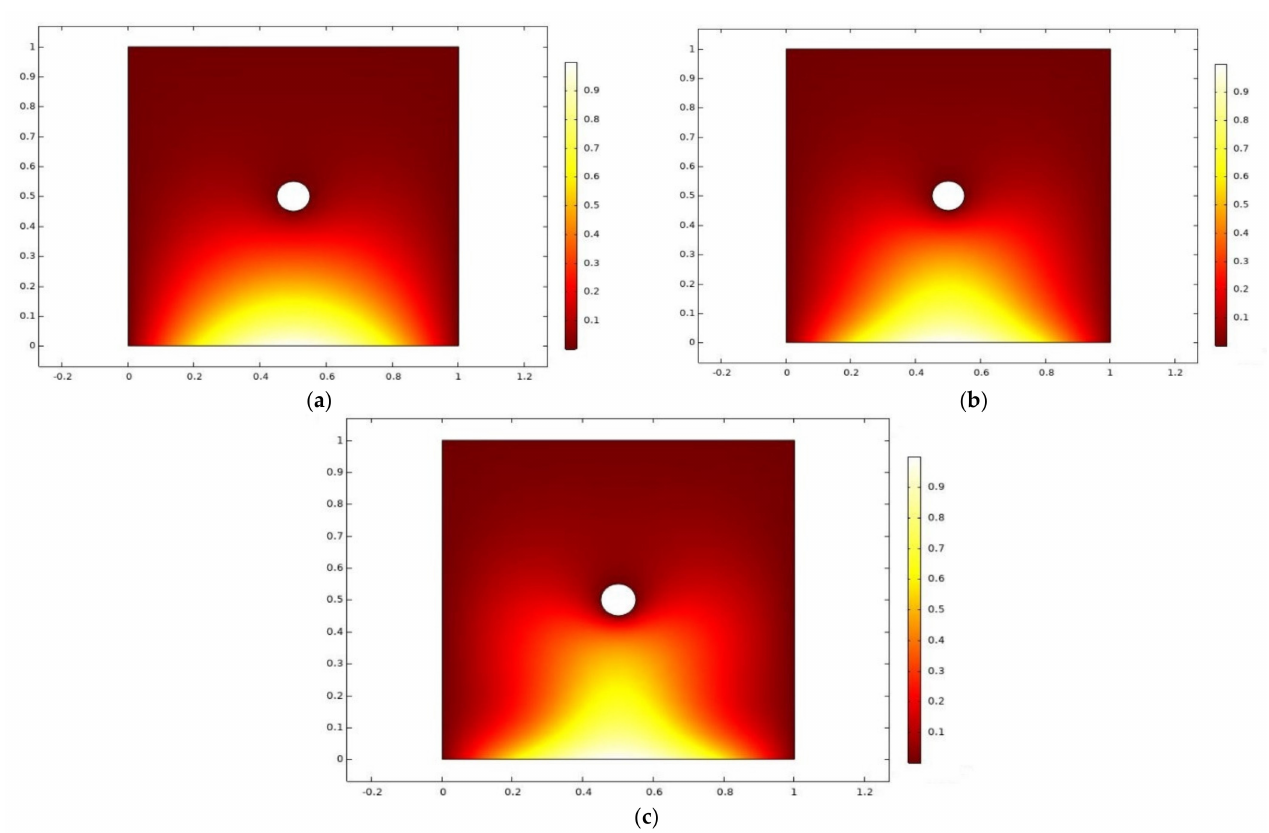
Figure 7. Impact of Prandtl number ( Pr ) on temperature distribution ( a ) Pr = 5, ( b ) Pr = 10, ( c ) Pr =